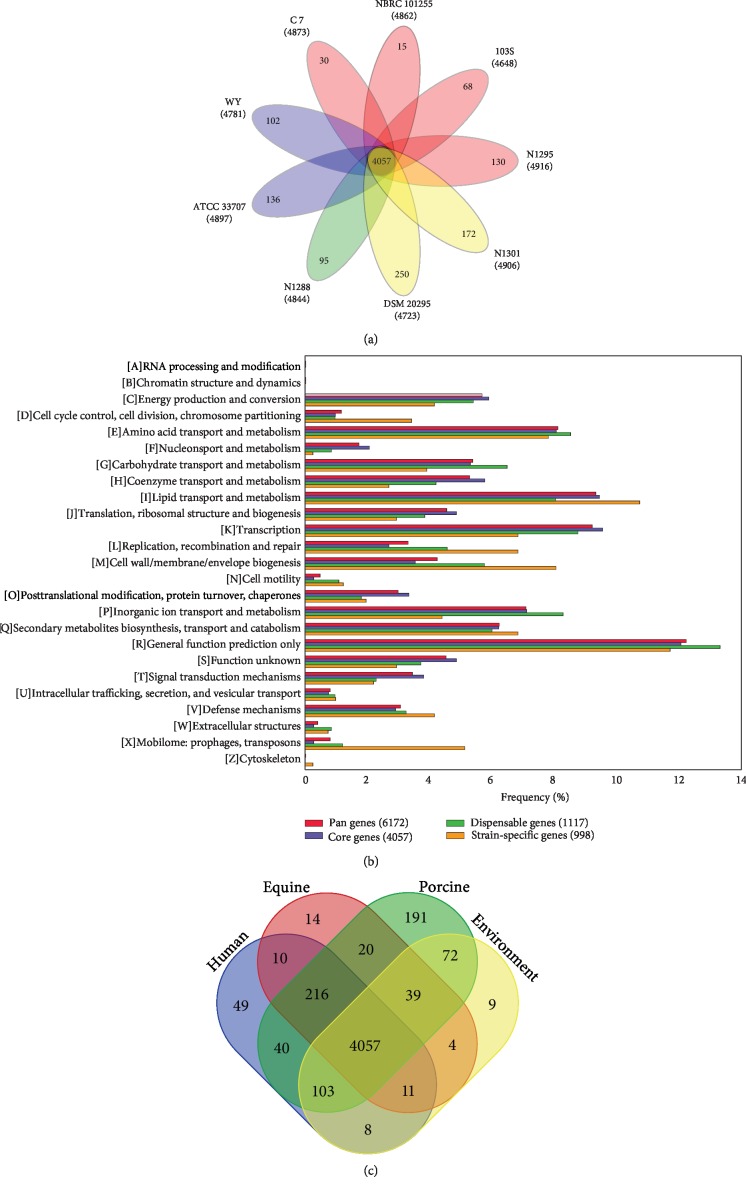
Pan-genome analysis of R. equi. (a) The core gene number (in the center) and strain-specific gene number (in the petals) in nine Rhodococcus strains as illustrated by a flower plot. (b) The COG function classification comparison of pan, core, dispensable, and strain-specific genes in R. equi. (c) Venn diagram of the four core genomes from four different sources (human, equine, porcine, and environment). The numbers represent the respective number of orthologous clusters. The petals in (a) are color-coded by source, and the colors are correlated with (c).